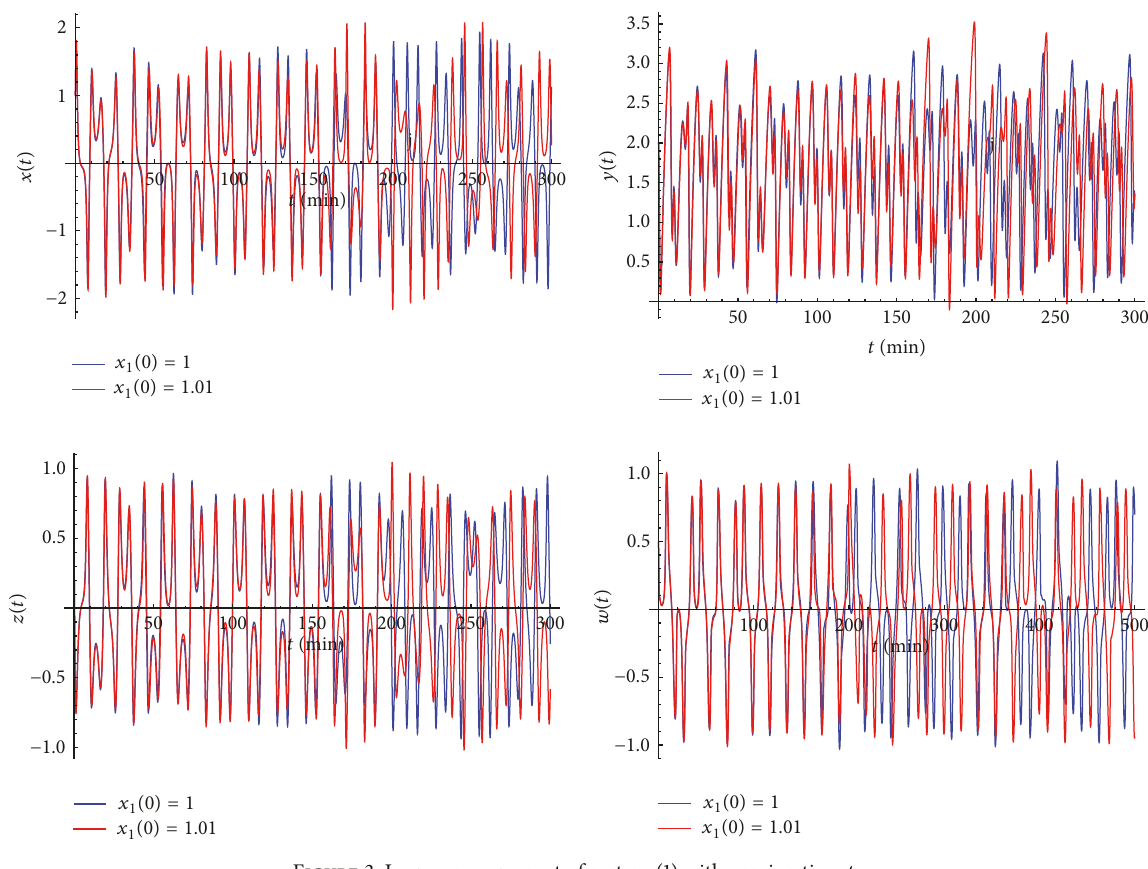
Figure 3: Lyapunov exponent of system (1) with varying time 𝑡